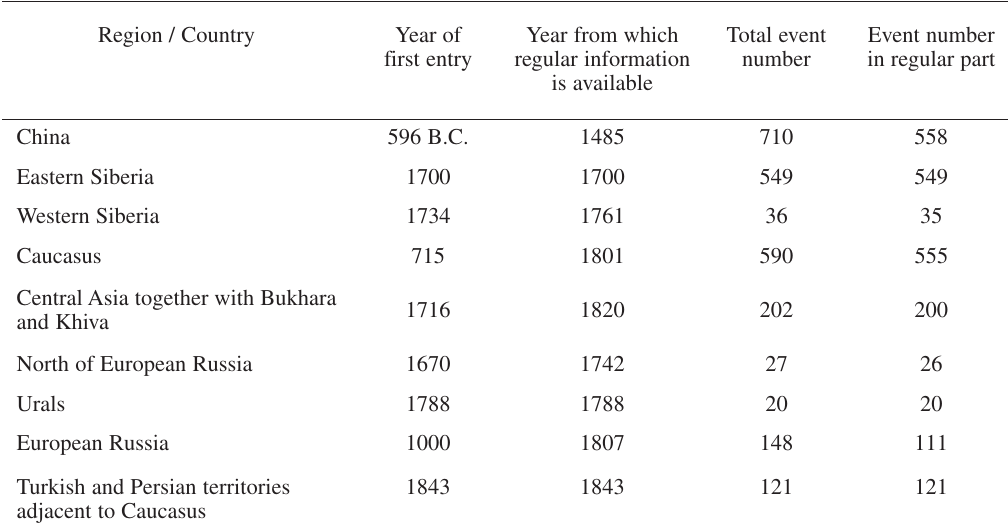
Table IV. Evaluation of data completeness of the earthquake catalogue from Mushketov and Orlov